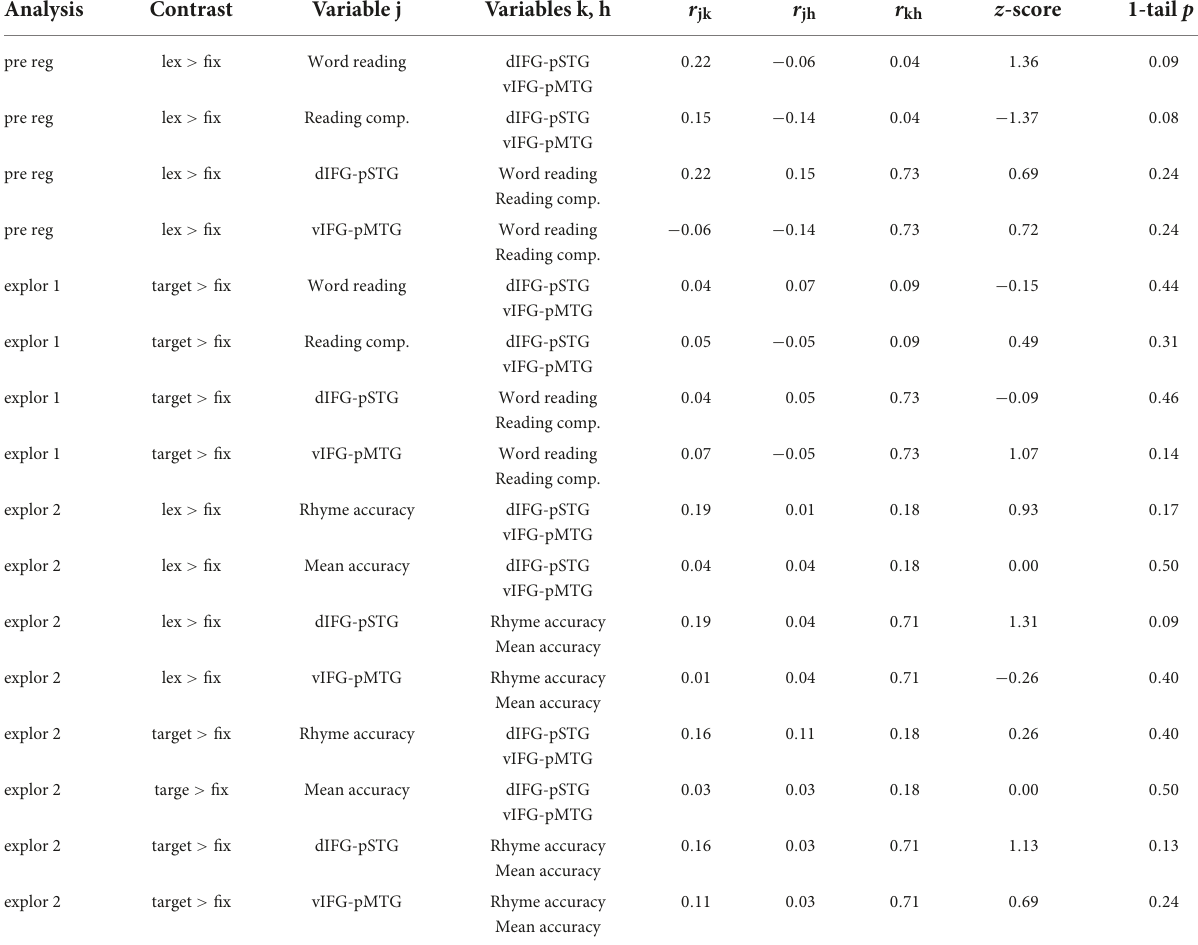
TABLE 2 Results comparing correlation coefficients from the preregistered analysis (pre reg) using the lexical > fixation contrast (lex > fix) and exploratory analyses (explor 1 and explor 2) using the target-conditions > fixation (target > fix) contrasts.